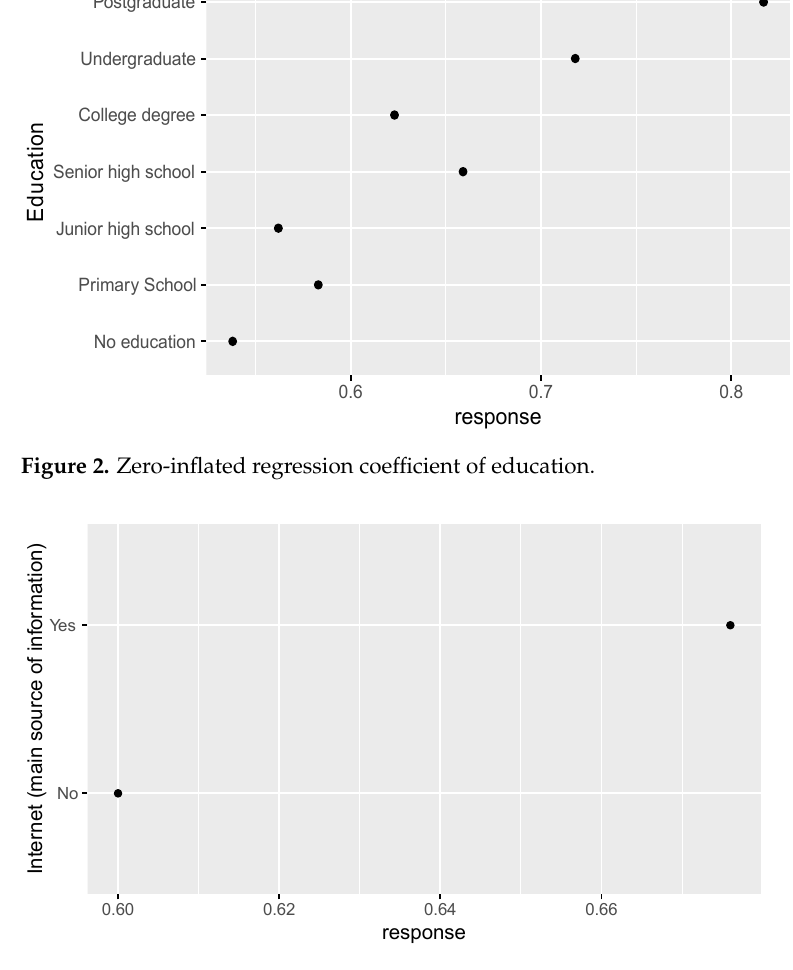
Figure 3. Zero-inflated regression coefficient of Internet. Figure 4. Zero-inflated regression coefficient of Internet Figure 4. Zero-inflated regression coefficient of Internet Figure 4. Zero-inflated regression coefficient of Internet